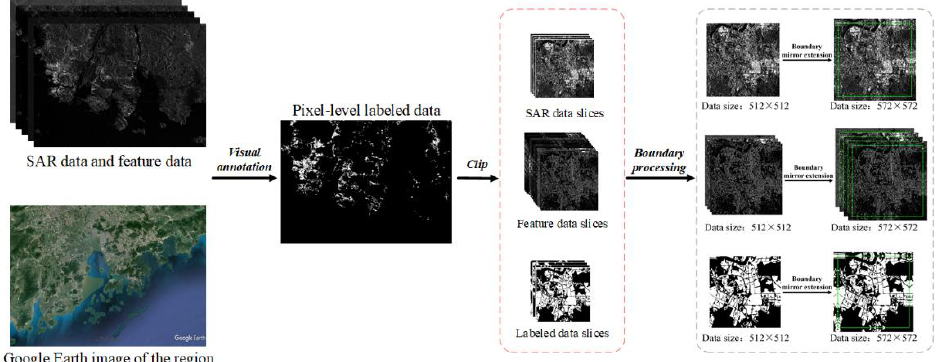
Figure 8. Schematic diagram for the production of the training sample set. Table 2. Basic information of training sample set.